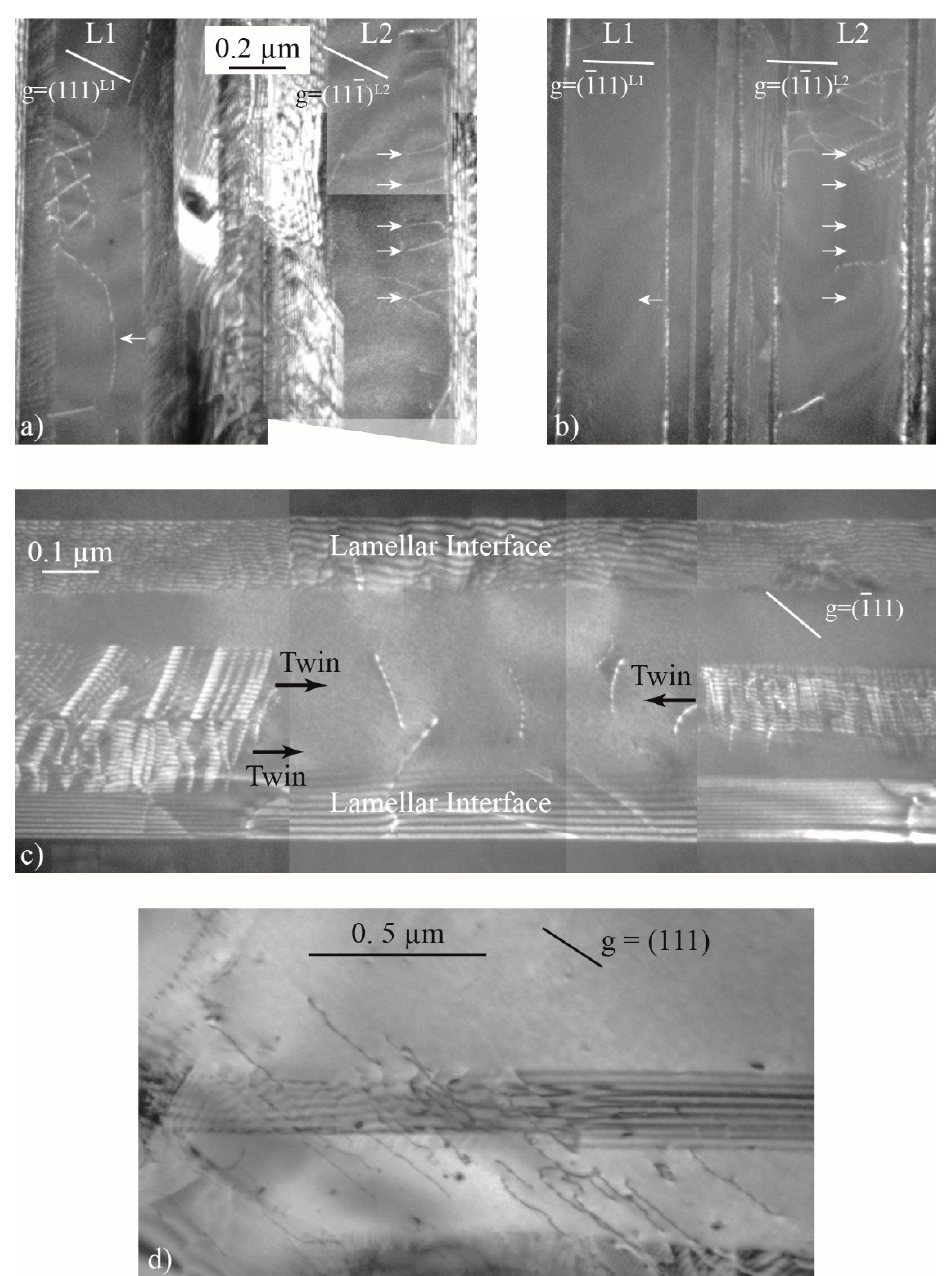
Figure 10. Several examples of deformed zones in thin foils extracted from TNM + specimens, which were deformed at room temperature. ( a , b ) Lamellae oriented in soft mode containing some ordinary dislocations which have glided in a plane parallel to the interface plane; ( c ) twins in a lamella oriented in soft mode; and ( d ) ordinary dislocations and a deformation twin in a γ zone of a border.